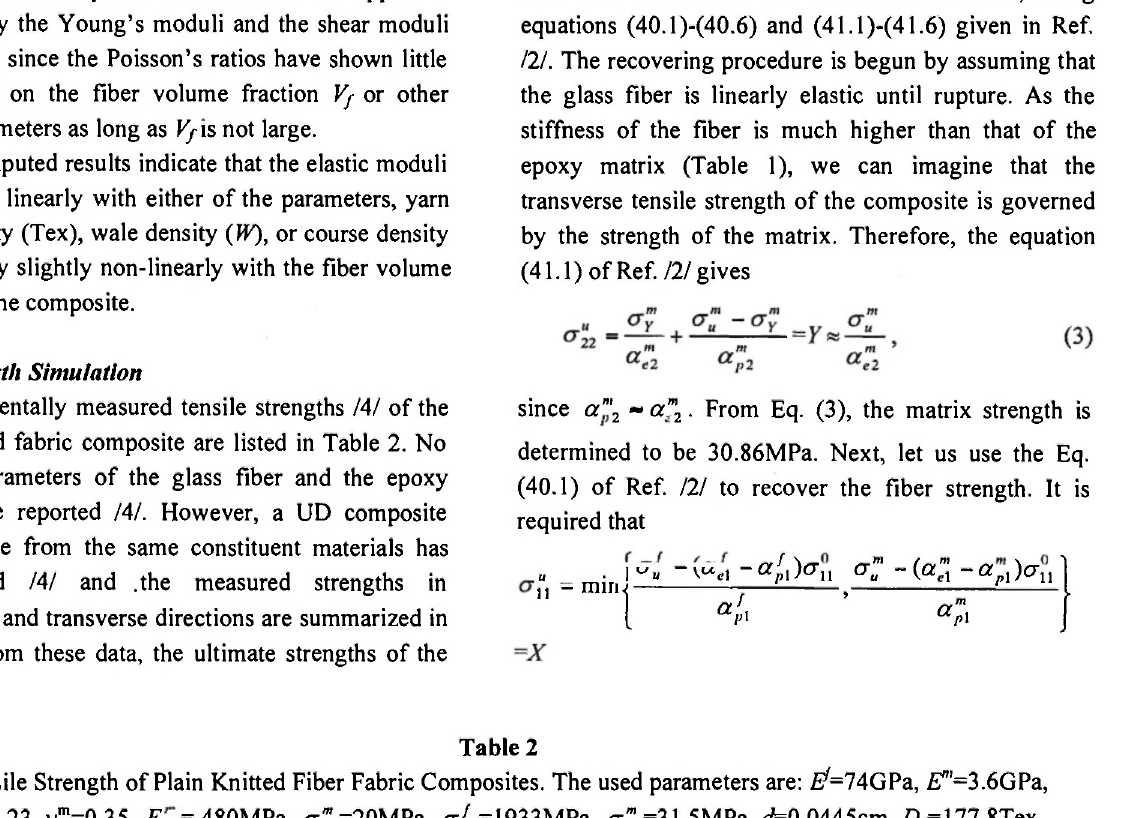
Tensile Strength of Plain Knitted Fiber Fabric Composites. The used parameters are: £ y =74GPa, £"'=3.6GPa, v f =0.23, v m =0.35, Ε j = 480MPa, a?=20MPa, σ/=1933MPa, σ™ =31.5MPa, i/=0.0445cm,